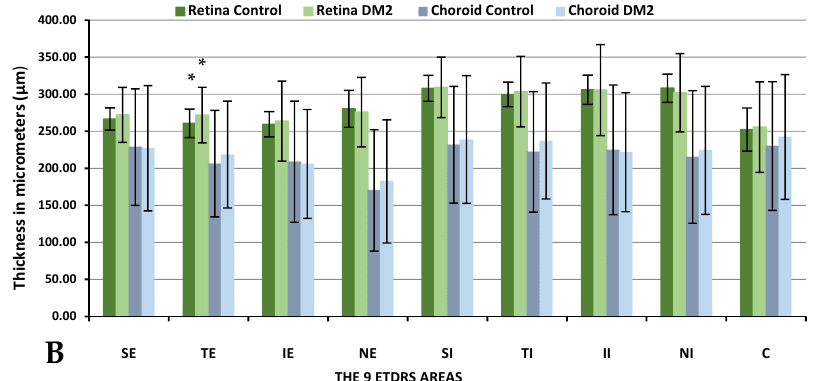
Figure 2. Mean and standard deviation (SD) of retinal and choroidal thicknesses measured using DRI-Triton SS-OCT in patients with type 2 diabetes mellitus (DM2) and in healthy controls and their comparison ( p -value): ( A ) The measurements are represented in the nine areas of the early treatment diabetic retinopathy study (ETDRS) grid. The left quadrants represent the temporal quadrants, and the right quadrants represent the nasal quadrants. Differences that reached statistical significance ( p < 0.05) are shown in red with a grey background. ( B ) Retinal and choroidal thicknesses are represented in a bar chart. Statistically significant differences ( p < 0.05) are marked with (*).